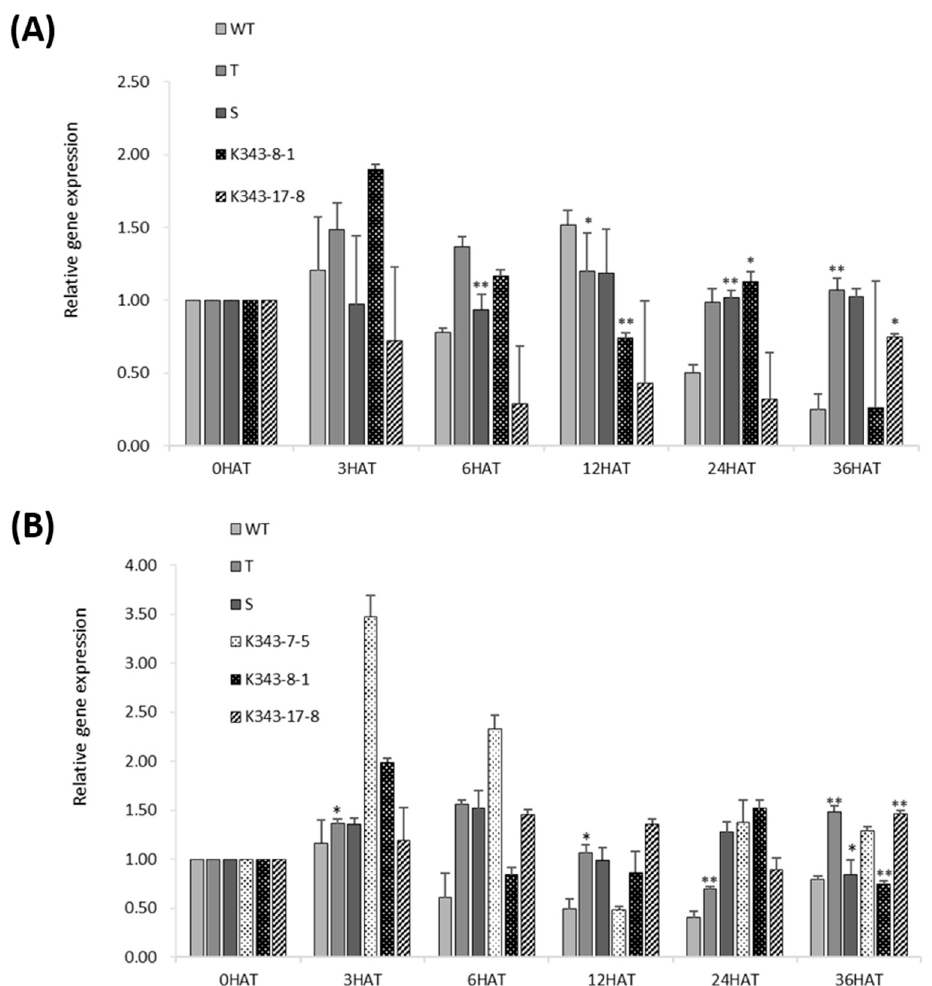
Figure 8. RNA expression patterns of OsPUB7 in response to drought and salinity stress treatment analyzed using qRT-PCR. Relative gene expression level was normalized to that of the rice actin gene, ACT1 . Values are presented as mean ± standard error. Three independent biological replicates were used. Bars represent standard deviations (SD) of three technical replicates. Significant differences according to t -test are indicated using asterisks (*, p < 0.05; **, p < 0.01).